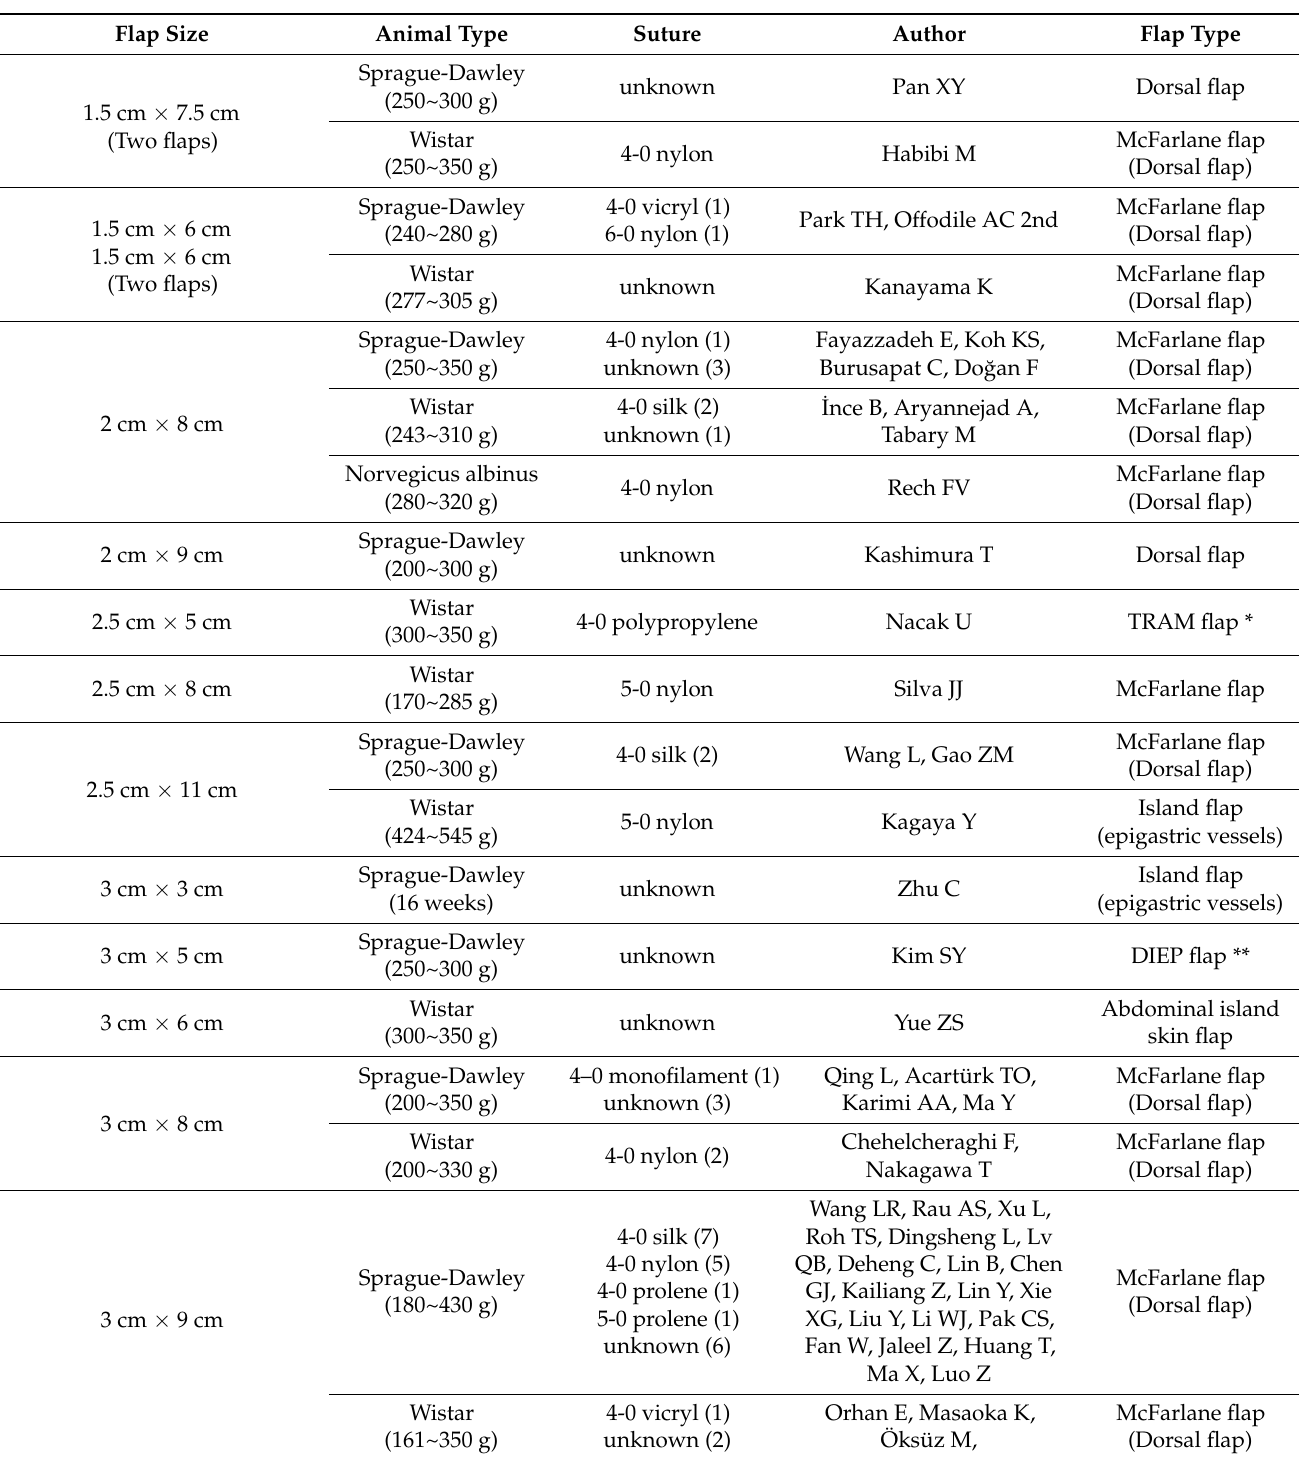
Table 1. Skin flap rat models: flap sizes and